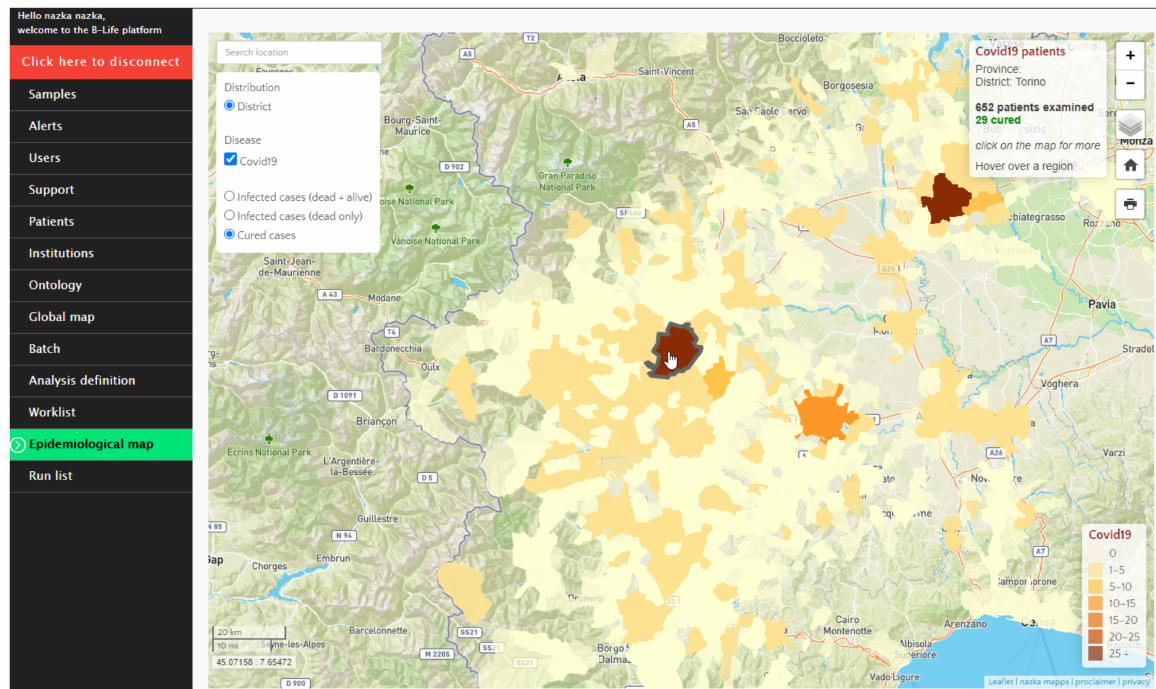
Figure 20. B-LiFE deployment in Turin, Italy, during the COVID-19 crisis: the epidemiological map including the information window on the top right of the map changes dynamically according to the position of the mouse on the map. It shows the name and the number of patients examined in the selected district and the number of infected or cured patients. Although this information was not required during the B-LiFE mission in Piedmont, other types of information, such as survival or death, can be added to the